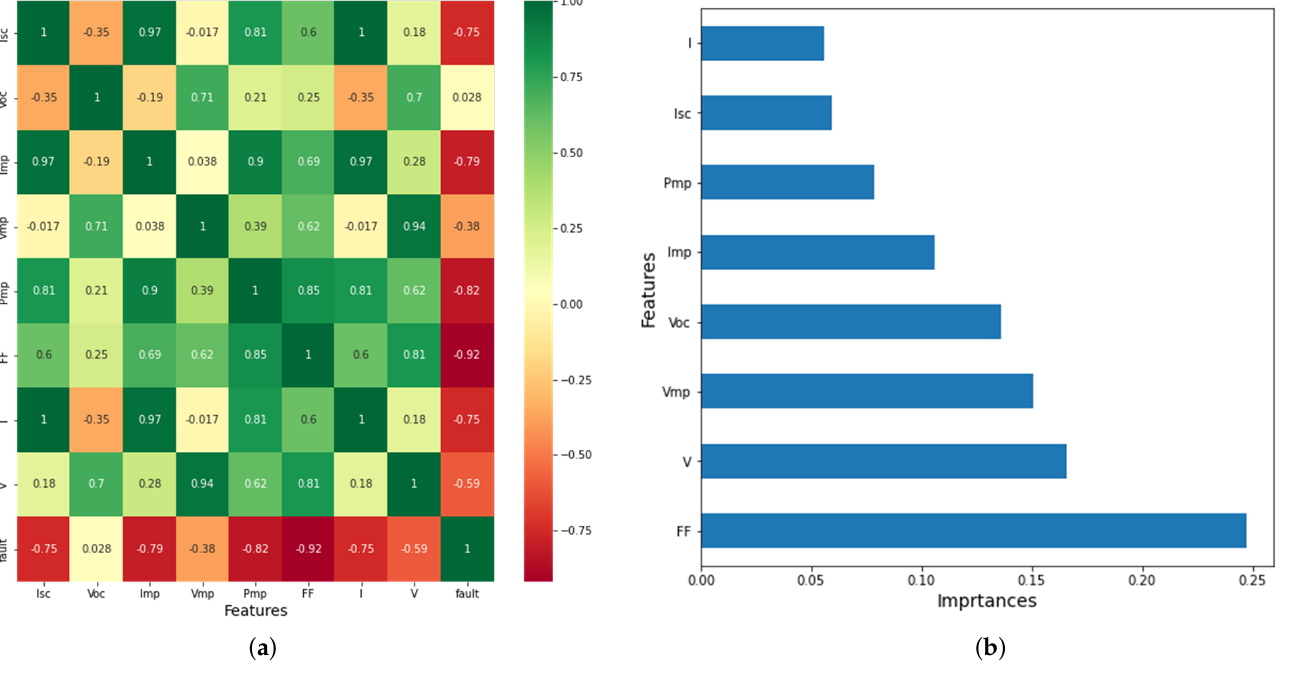
Figure 9. ( a ) Correlation and heat map, ( b ) importance